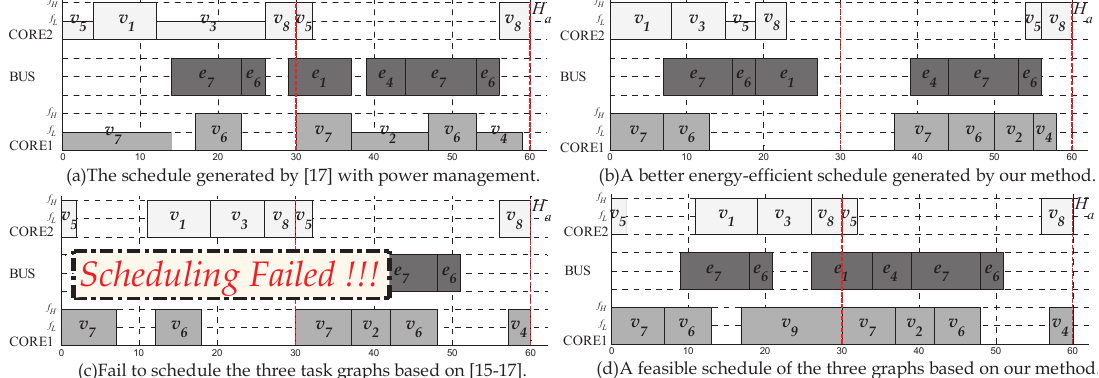
Figure 5. A motivating